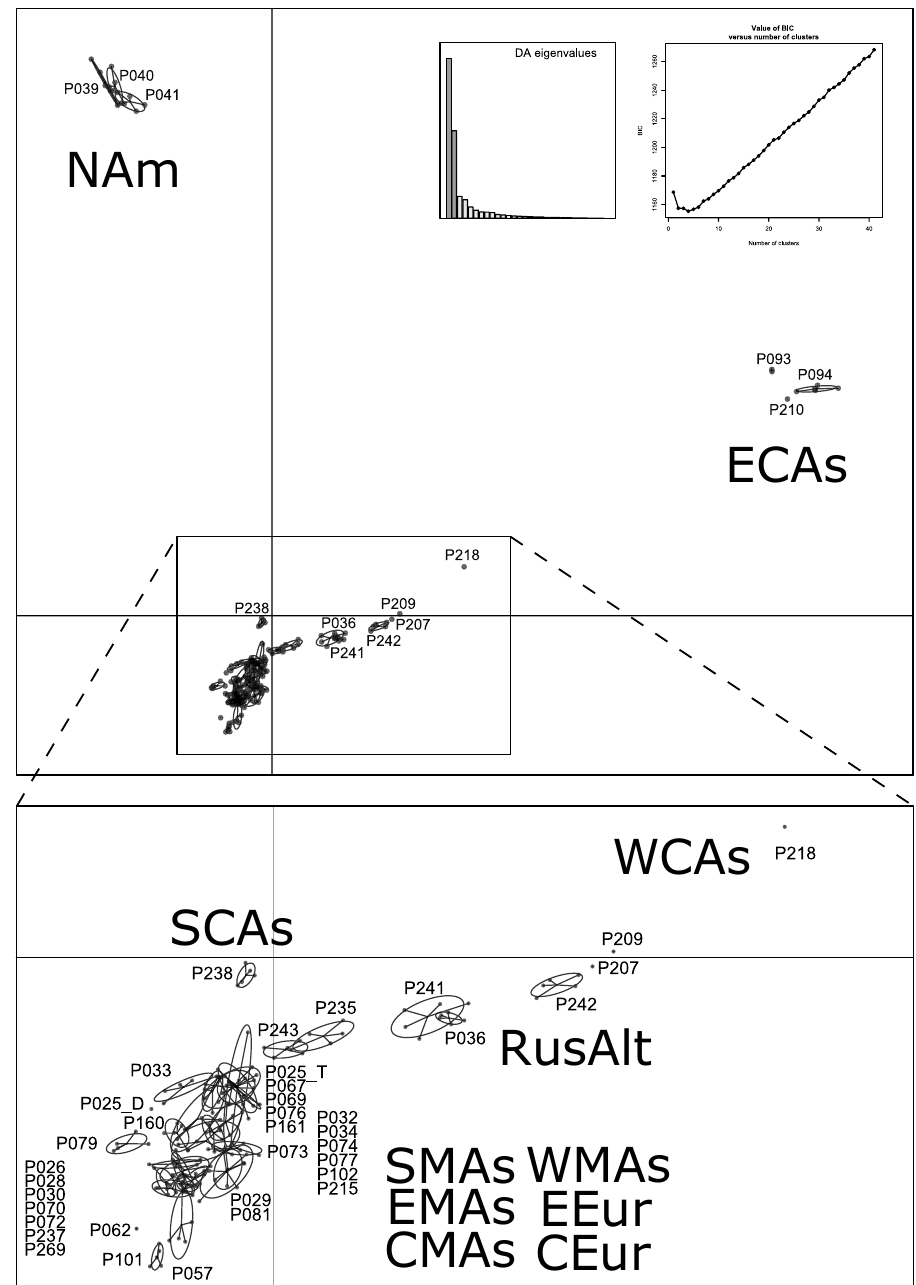
Figure 4. Genetic clustering of samples as calculated by dapc package of R. Four clusters were retained. One cluster comprises the European populations, one the Middle Asian and southern Central Asian populations, one the populations of western Central Asia and the Russian Altai, and another the eastern Central Asian and North American populations. The figure was generated in R and edited in Inkscape v1.0.2 (https:// inksc ape.